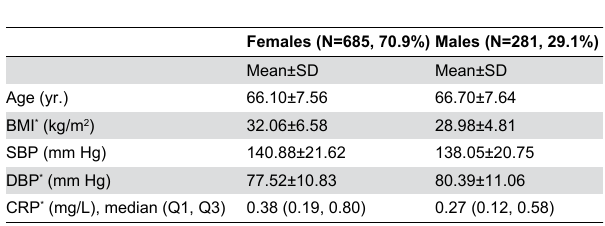
Table 1. Summary of demographic variables.